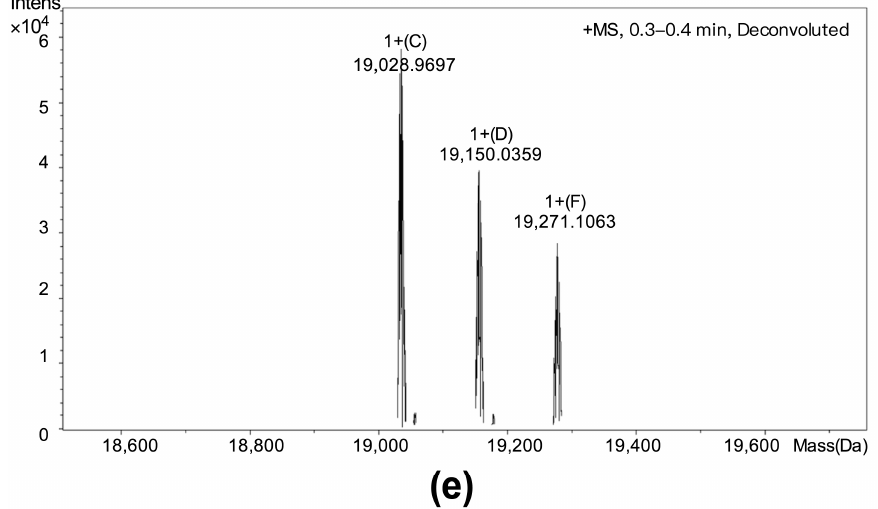
Figure 1. Purification and identification of polypeptide PBN11-8. ( a ) Purification of the crude polypeptide by strong anion-exchange chromatography on a HiPrep Q FF 16/10 column. ( b ) Purification of the Q chromatographic fraction Q2 by high performance liquid chromatography (HPLC) on a Protein-PAKTM 60 column. ( c ) Detection of polypeptide by 12% sodium dodecyl sulfate-polyacrylamide gel electrophoresis (SDS-PAGE). Lane M:MW Mark; Lane 1: total proteins; Lane 2: ammonium sulfate precipitation; Lane 3: strong anion exchange fraction; Lane 4: purified polypeptide. ( d ) Purity analysis of P1 by analytical Protein-PAKTM60 hydrophilic molecular exclusion chromatography. ( e ) The electrospray-ionization (ESI) mass spectrum of the P1.